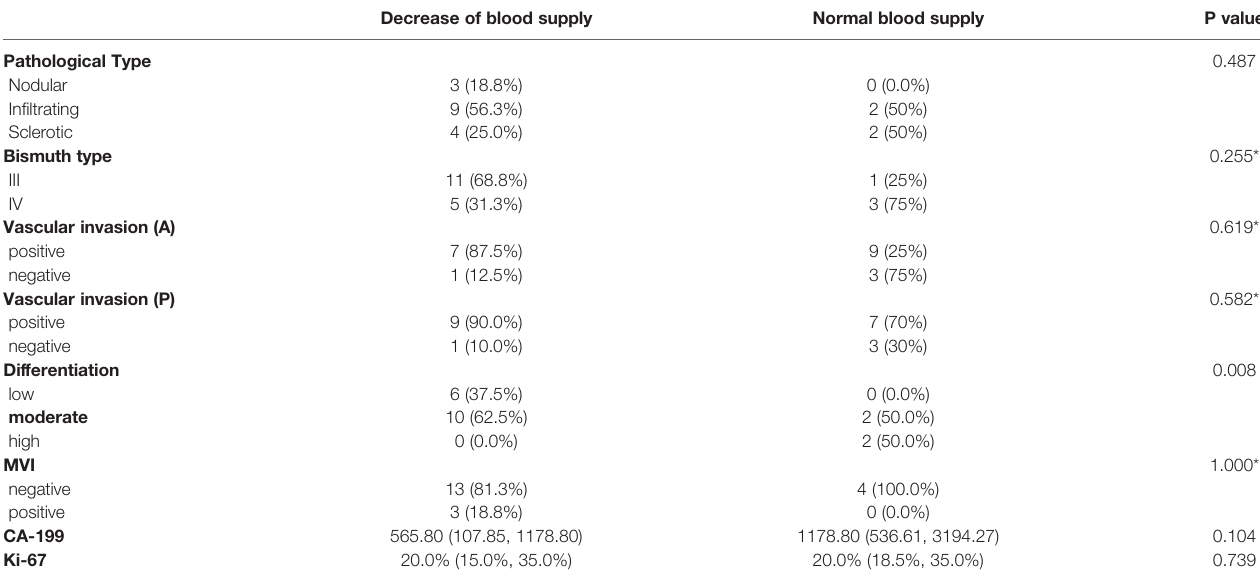
TABLE 3 | Risk factors of PNI. Decrease of blood supply Normal blood supply P value Pathological